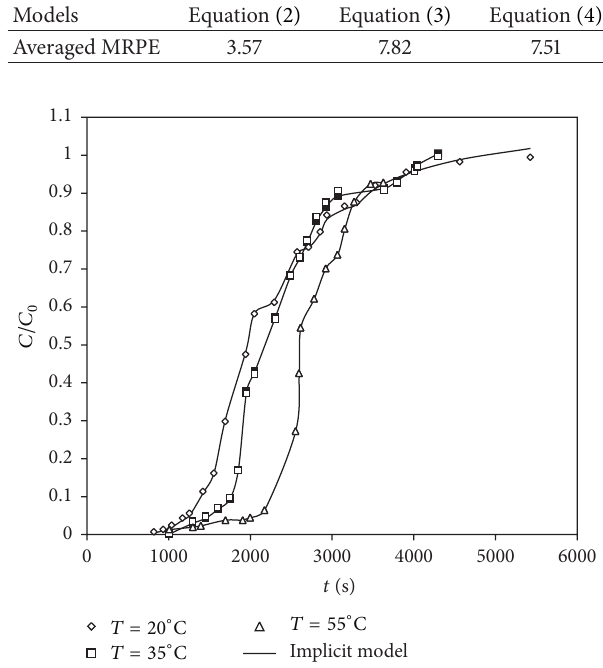
Figure 2: Citric acid adsorption breakthrough curves data points fitted by (2) at 20, 35, and 55 ∘ C